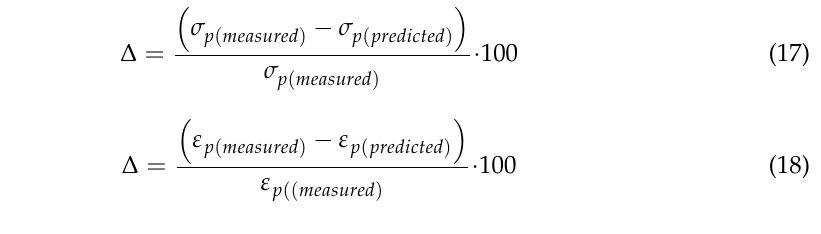
Table 4. Accuracy of σ p values predicted according to Equation (5).